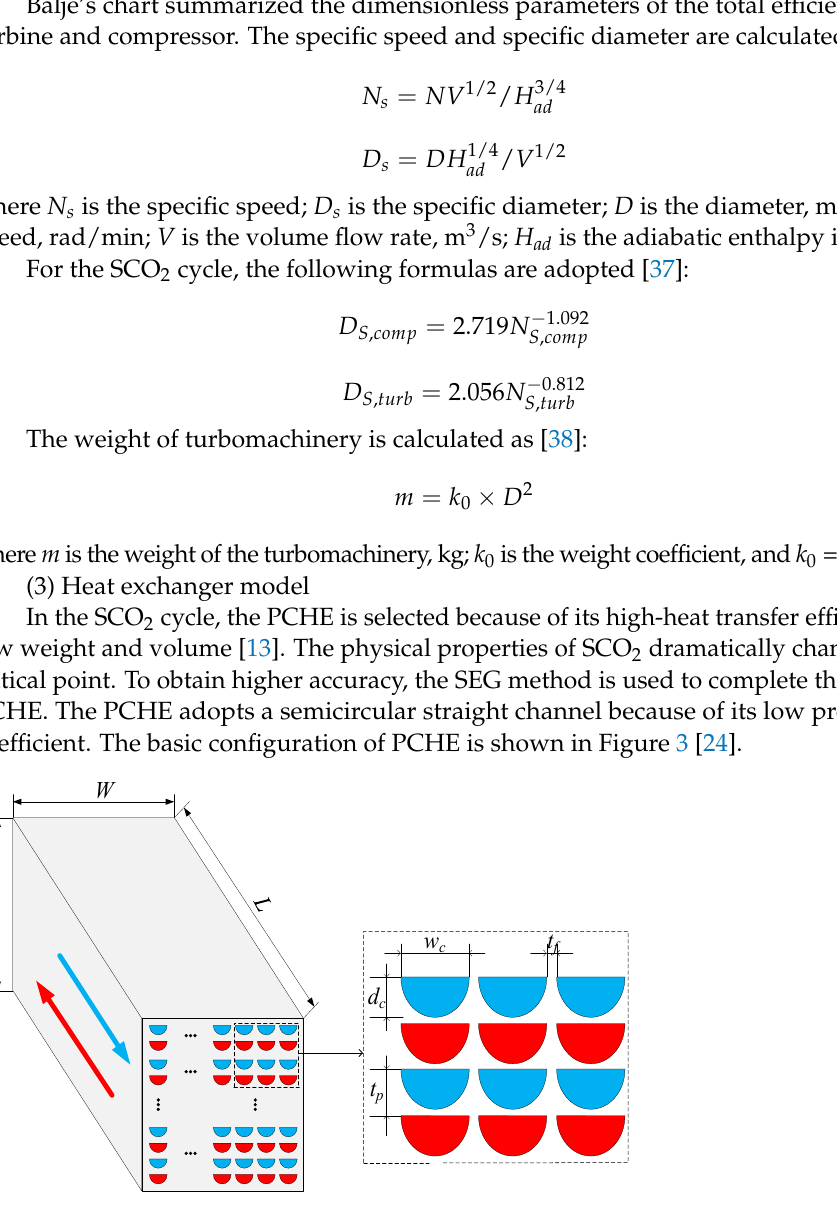
Figure 3. PCHE configuration and basic parameters.